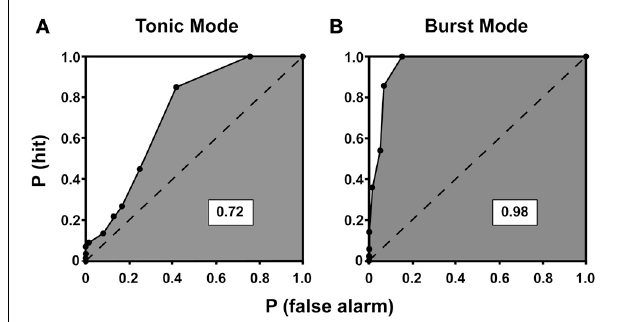
FIGURE 8 | ROC curves for tonic (A) and burst (B) mode of response for a neuron recorded from the lateral geniculate nucleus of a cat. The ROC curves plot the probability of correctly detecting visually-driven activity from spontaneous activity. The probability of detecting the signal, P(hit), is plotted on the y-axis against the probability of mistaking spontaneous activity for visually driven activity, P(false alarm), at all possible criterion levels. The area under each curve is shaded, and the dashed line divides the total area of the curve in half. A value of 1 indicates perfect detection of signal from noise whereas a value of 0.5 indicates that signal and noise are indistinguishable. Here, the area under the curve is higher for burst mode compared to tonic mode, indicating enhanced signal detection conferred by the burst mode of response [reprinted with the permission of Cambridge University Press and adapted from Guido et al.